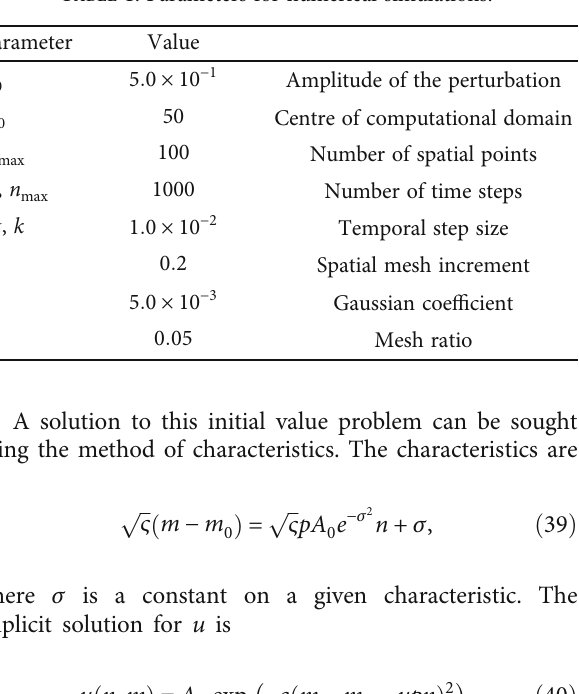
Figure 1: Solution of (1) obtained from the FDTD algorithm (FDTD1) (31). Plots display spatial structure, m , for time steps n = 0 (initial conditions), 250 , 500 , 750 , and 1000 exhibiting the evolution of the nonlinear wave and the advective instability. The nonlinear wave has a propagation speed proportional to its amplitude; therefore, the crest of the perturbed wave structure moves faster than its base. As a result, the crest of the wave tries to overtake the smaller amplitudes requiring a multivalued solution, forbidden in this numerical framework resulting in instability. The FDTD solution plotted here exhibits the qualitative behaviour of the numerical methods used in this paper. Table 1: Parameters for numerical